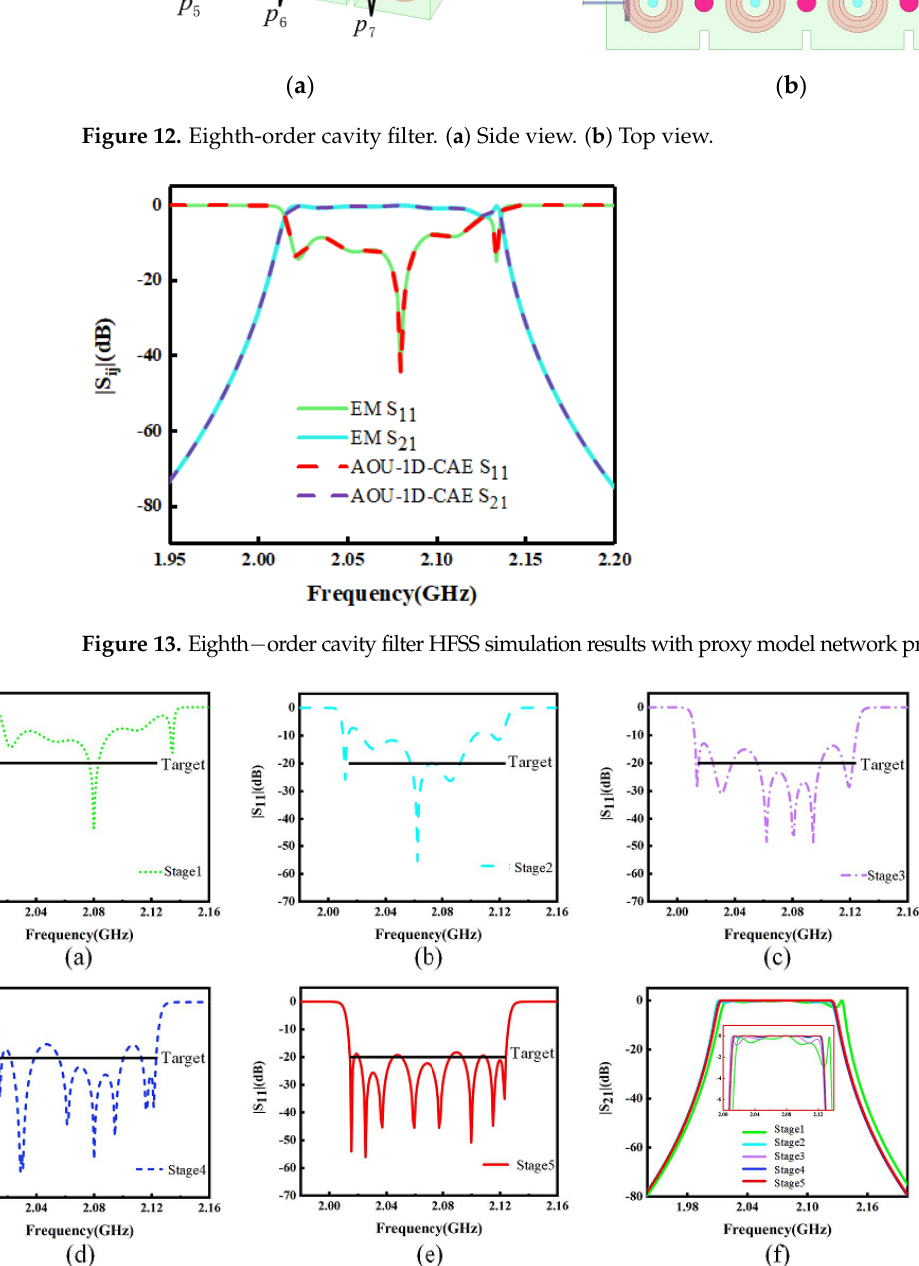
Table 3. Eighth-order cavity filter optimization process.